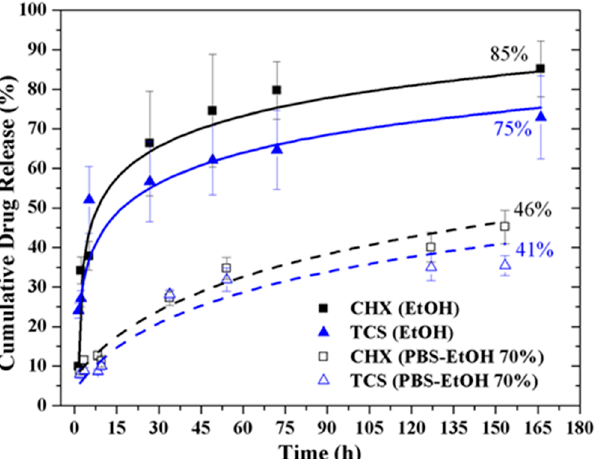
Figure 12. Release profile of PLA samples loaded with 3 wt-% of TCS (blue) and CHX (black) in absolute ethanol (solid lines) and PBS-EtOH 70% (dashed lines).